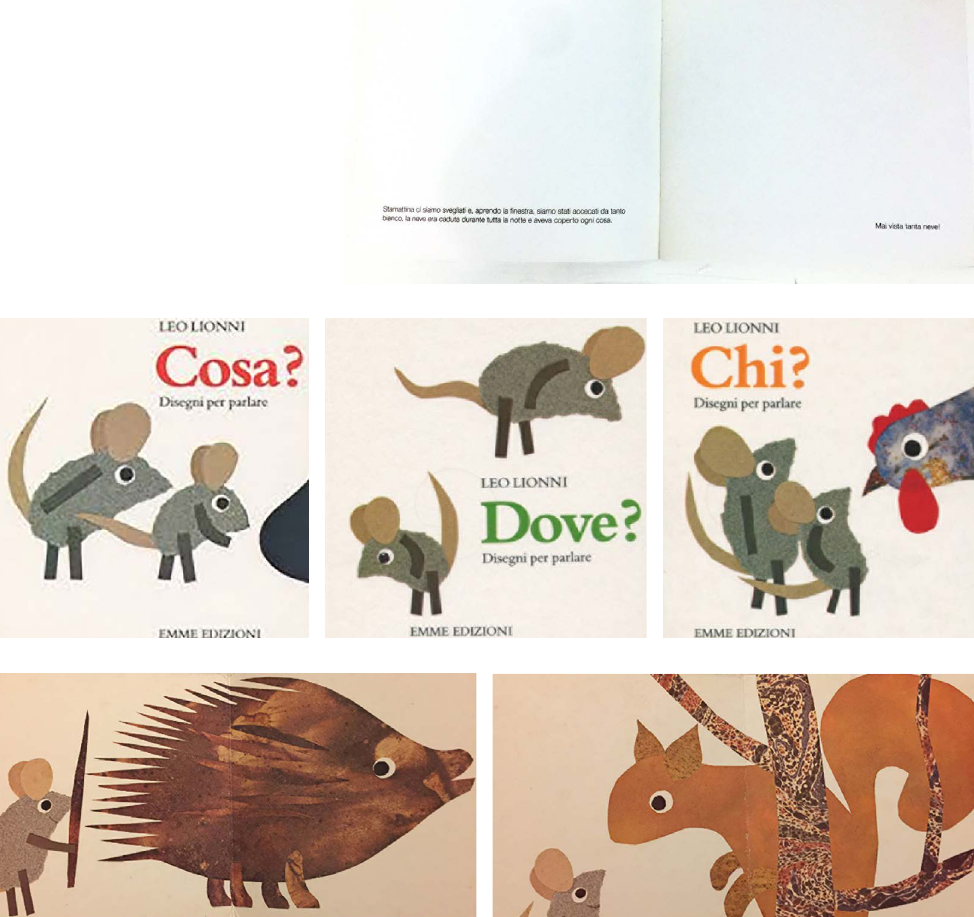
Fig. 20 Leo Lionni, Disegni per parlare , 1991. Fig. 21 Leo Lionni. Chi? Disegni per parlar e,